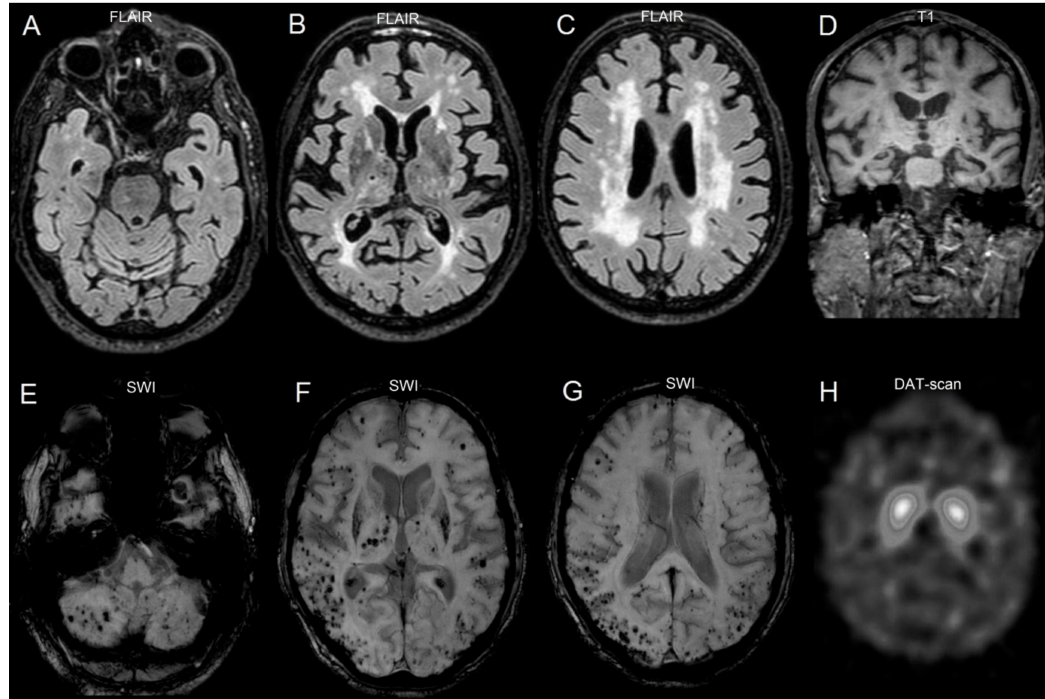
Figure 1. Neuroimaging of the patient. Axial Fluid Attenuation Inversion Recovery (FLAIR) images indicate white matter hyperintensities from the level of the pons up to corona radiate ( A – C ), while some lacunes are also present at the level of basal ganglia and thalami (B). Despite neocortical atrophy shown in B and C, coronal T1 image ( D ) indicates relative preservation of the hippocampus, but additional presence of some lacunes. Axial susceptibility weighted images (SWI) show multiple microbleeds in the cerebellum ( E ), basal ganglia ( F ) and cortical-subcortical locations with a posterior preference ( F , G ). DAT-scan ( H ) indicates reduction of dopamine transporter activity, with some degree of